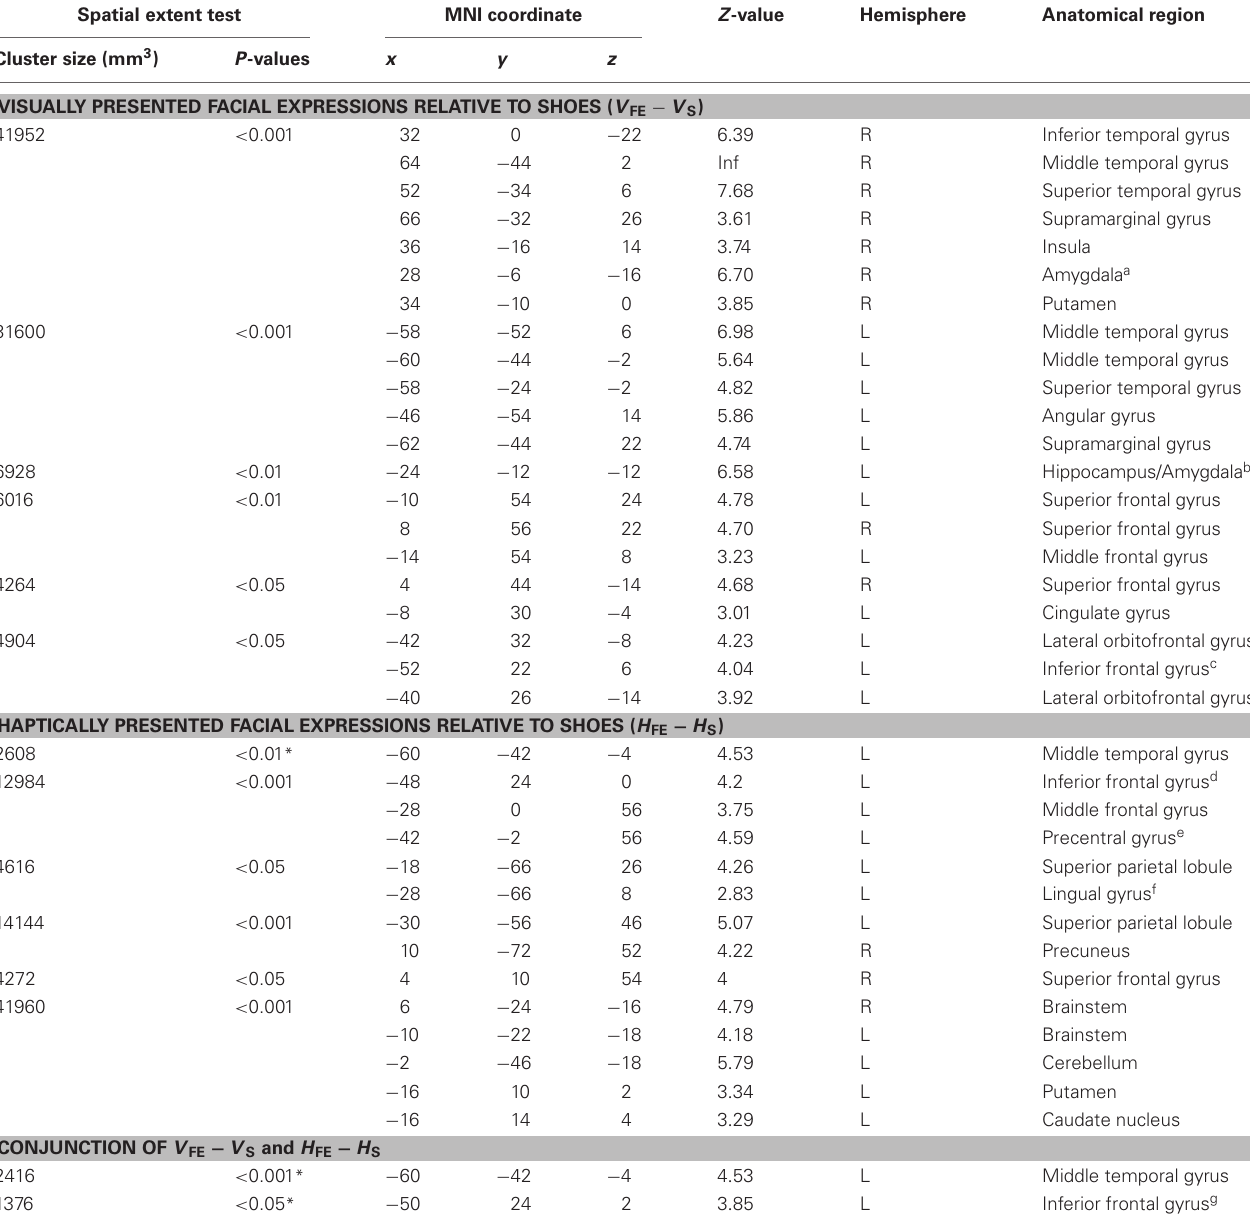
Table 2 | Group analyses of the brain regions in the sighted subjects. Spatial extent test MNI coordinate Z -value Hemisphere Anatomical